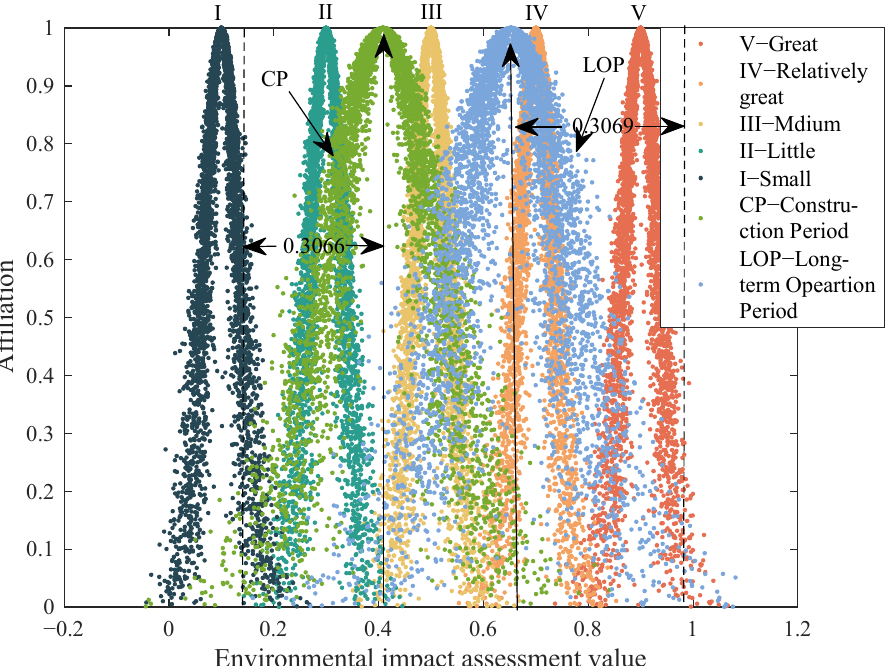
Figure 6. Cloud map of comprehensive evaluation in the construction period (CP) and long-term operation period (LOP).